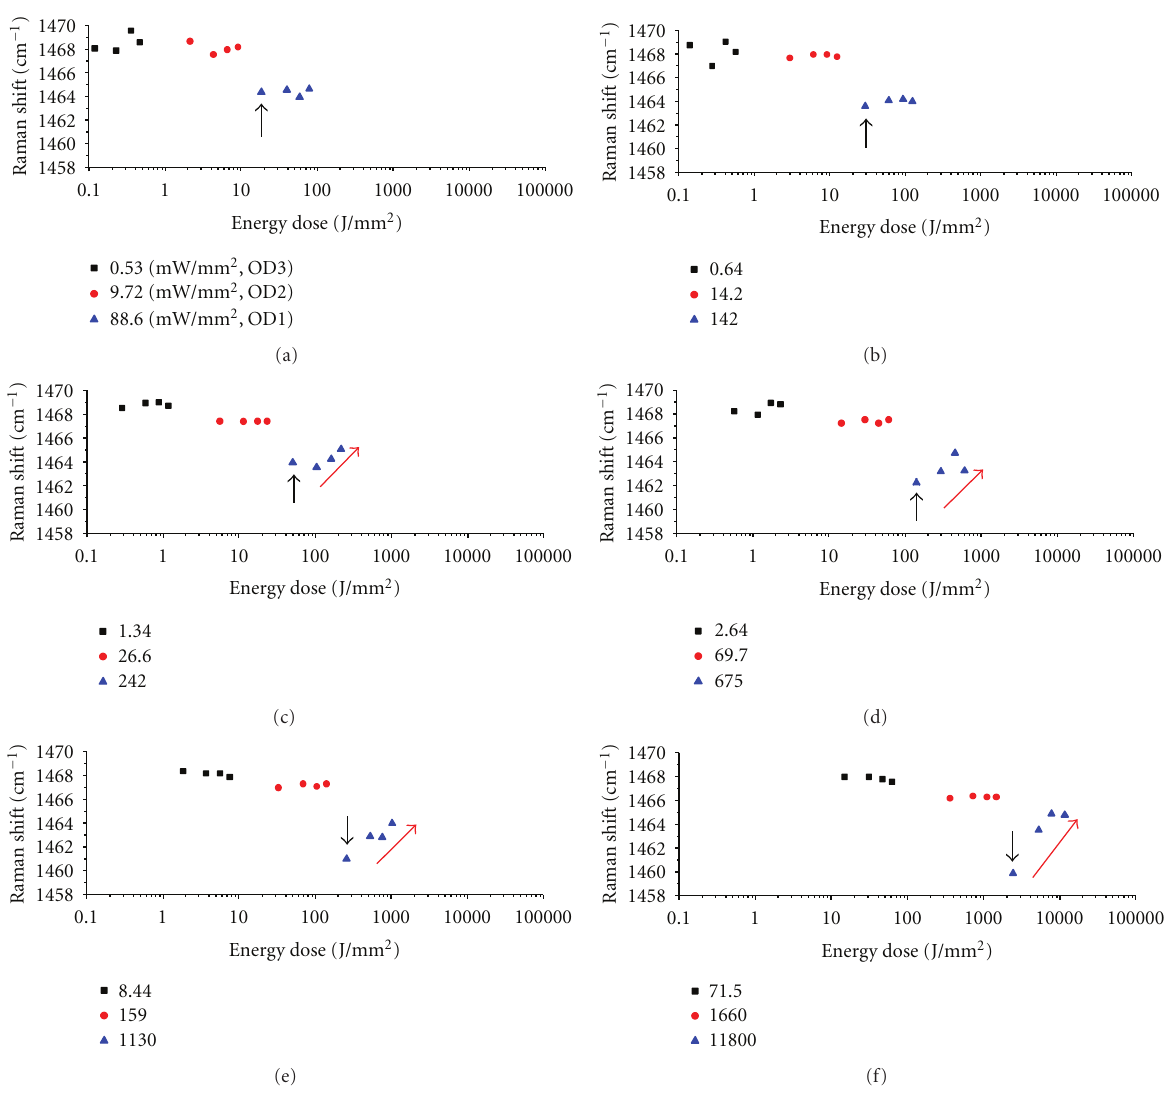
Figure 6: A g (2) peak positions of the Raman spectra of C 60 NWs under various exposure conditions at the defocus values of (a) 100 µ m, (b)